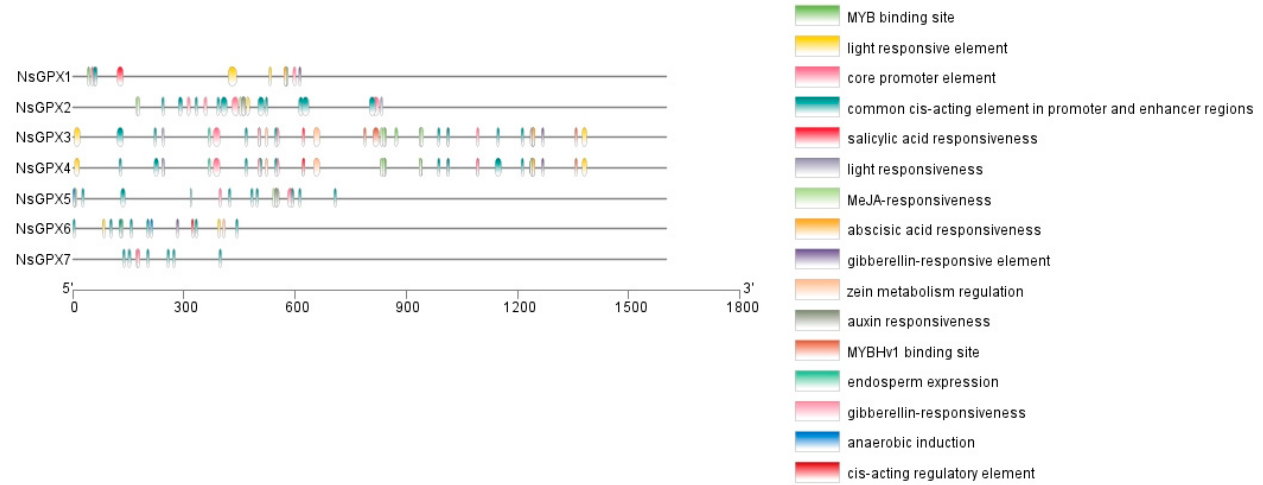
Figure 5. Evaluation of cis -regulatory elements in the NsGPX s promoters’ regions that are linked with assorted hormone- and stress-responsive elements. Specific color blocks represent unique identified cis -elements.